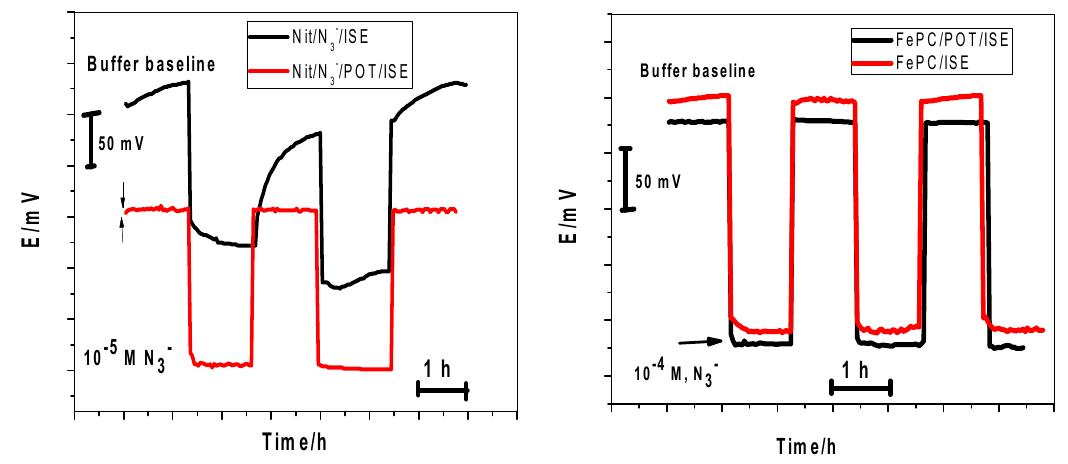
Figure 5. Effect of water-layer on azide membrane sensors with and without POT solid contact.